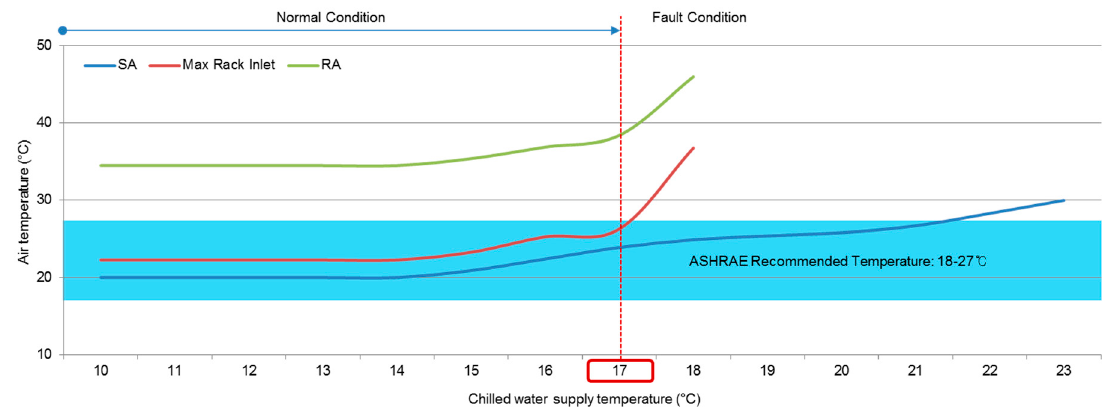
Figure 12. Maximum IT server inlet air temperature according to the SA and chilled water conditions. Table 5. IT cooling system for a typical floor.